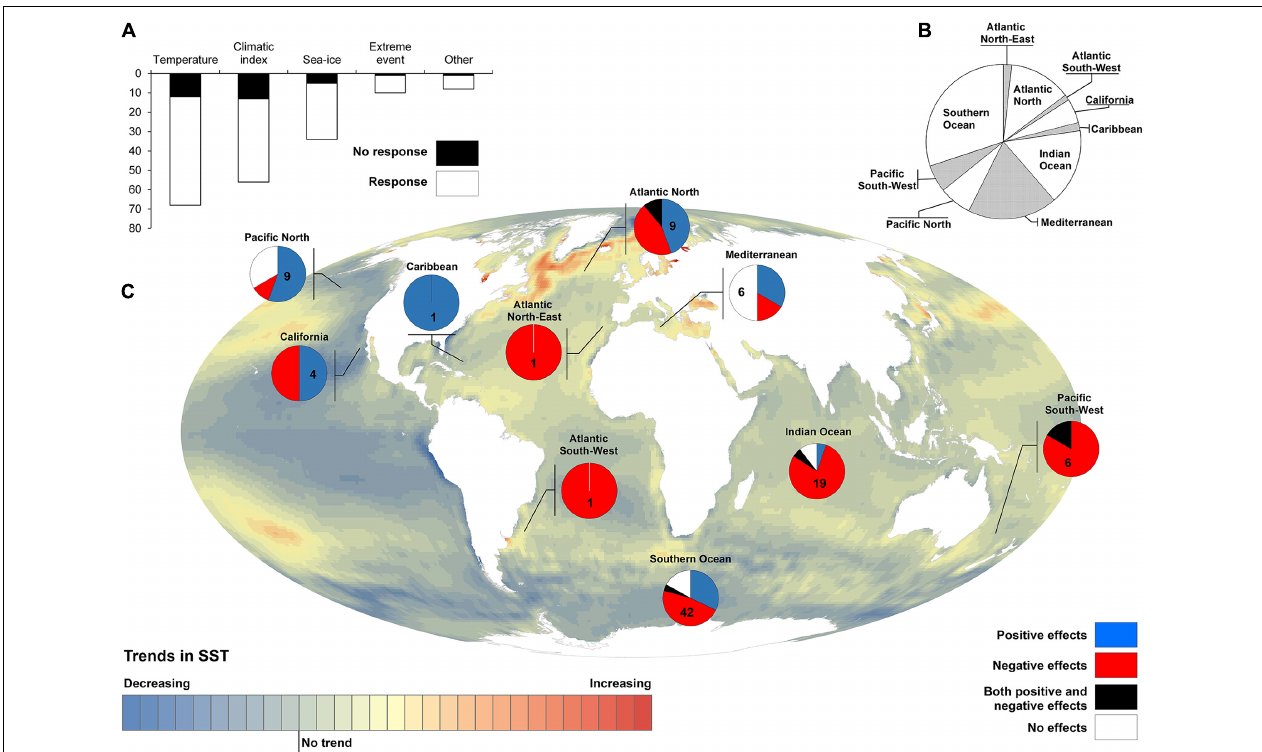
FIGURE 4 | Reported seabird responses to climate driven environmental changes. We compiled 64 studies ( Supplementary Material ) reporting up to 176 cases in which petrel and shearwater species responded (any kind of response, 144) or not (32) to environmental features such as air or sea temperatures, large-scale climatic indexes, sea-level or extreme weather events (A) . These responses were grouped geographically to elucidate the spatial heterogeneity in the distribution of reported responses (B) . Responses that could be directly interpreted as a benefit or a threat for seabirds (e.g., changes in breeding performance or survival rates; but not in breeding phenology or distribution) when facing climate driven environmental changes (e.g., increasing temperatures and extreme weather events or decreasing extents of sea-ice; but not large-scale climatic indices) were selected and grouped geographically to show the spatially explicit effects of climate change on petrel and shearwater populations; colored background represents the pixel-basis long-term (1983–2014) trend in sea surface temperature (SST) (Ramírez et al., 2017a) (C)